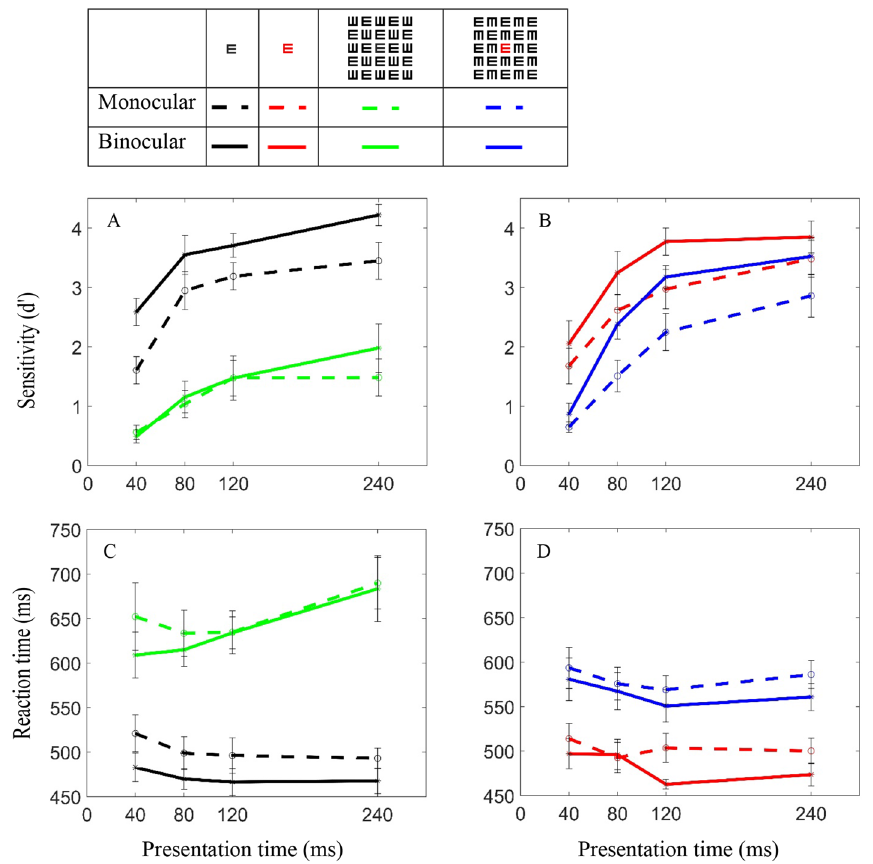
Figure 2. Single letter versus Crowding: Sensitivity: ( A ) for a black target letter. ( B ) For a red target letter. Reaction time: ( C ) for a black target letter. ( D ) For a red target letter. Continuous lines and plus symbols denote binocular vision; dashed lines and circles denote monocular vision. Black denotes a single black target letter and red denotes a single red letter. Green denotes black crowding and blue denotes red crowding. Error bars represent ± SE (standard error) of the